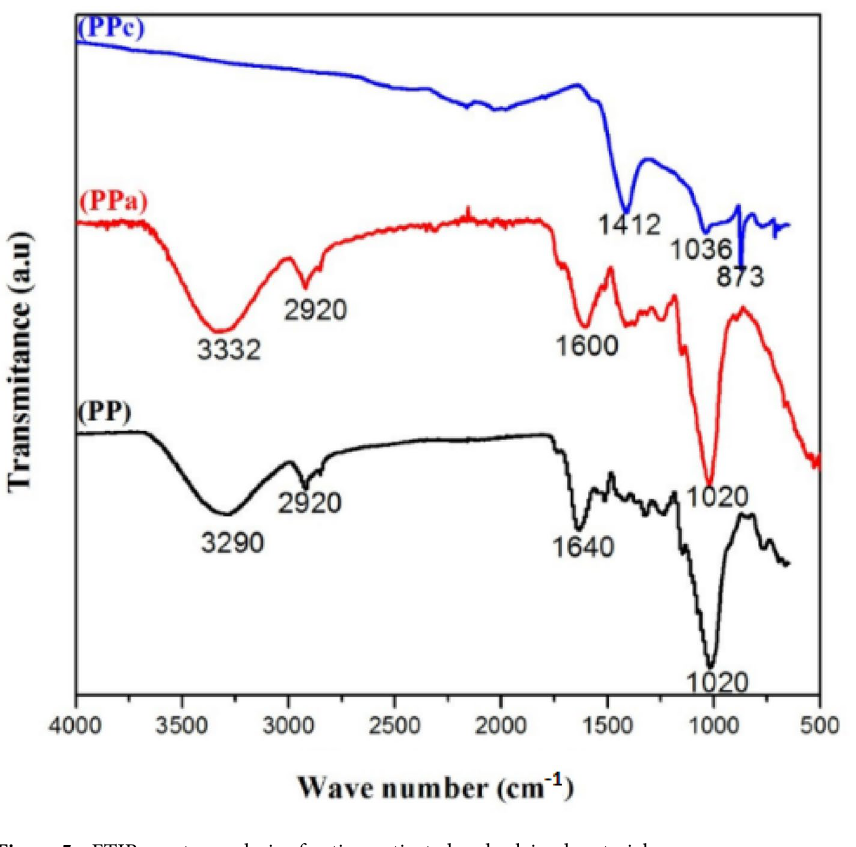
Figure 5. FTIR spectra analysis of native, activated and calcined materials.